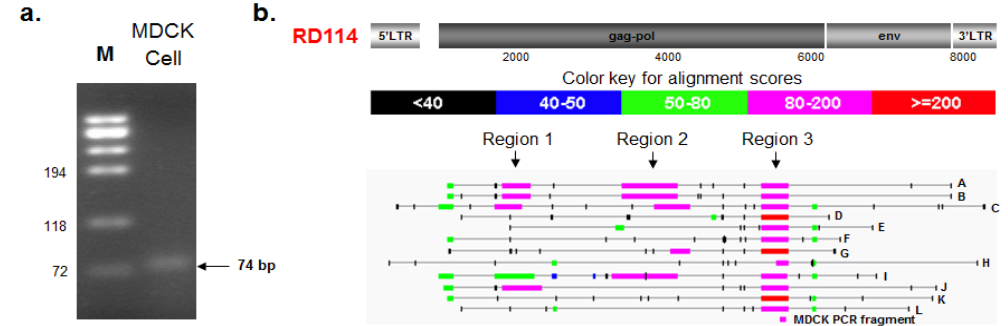
Figure 2. Follow up analysis of the PLEX-ID RD114 signal. ( a ) A 74 bp